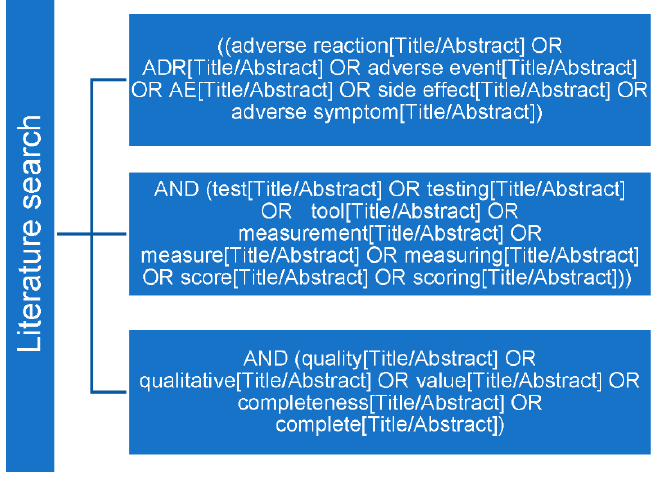
Figure 4. Literature search.